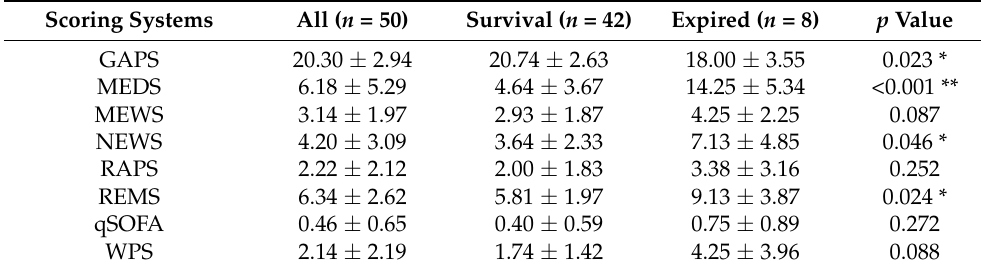
Table 3. Scoring systems for predicting the clinical outcomes of